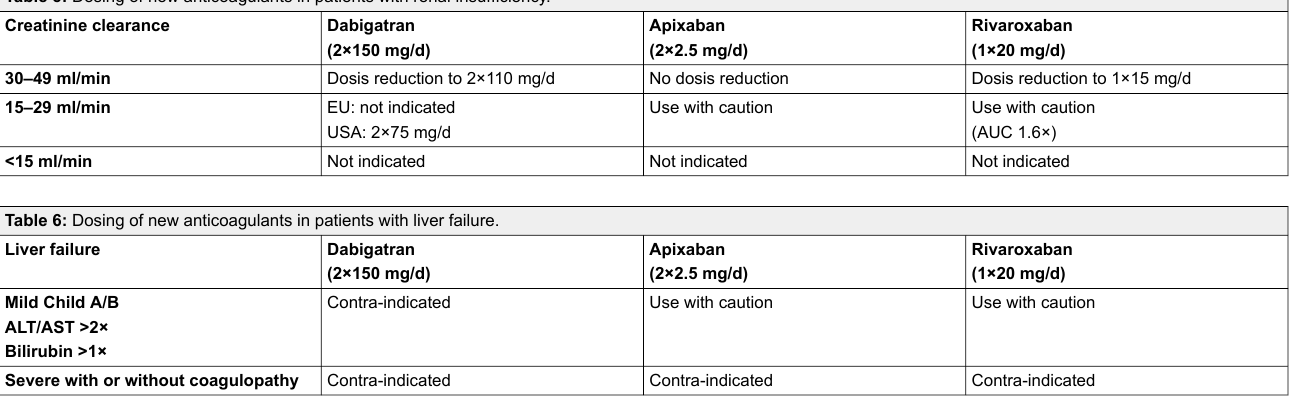
Table 5: Dosing of new anticoagulants in patients with renal insufficiency. Creatinine clearance